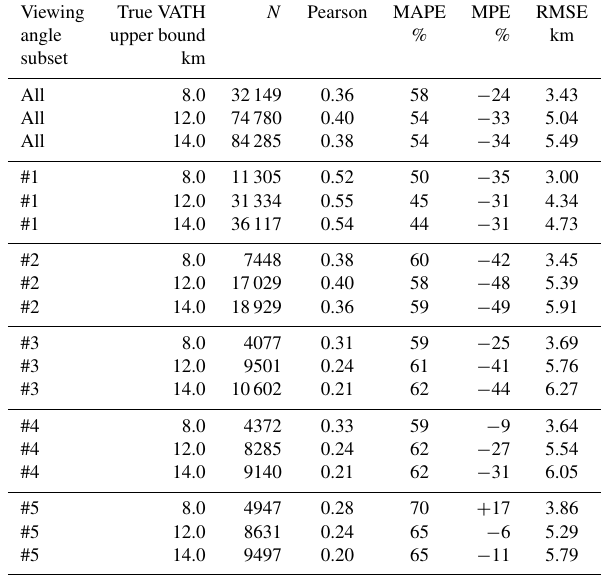
Table 2. Statistical evaluation of VATH from VADUGS against sim- ulated observations (representing the